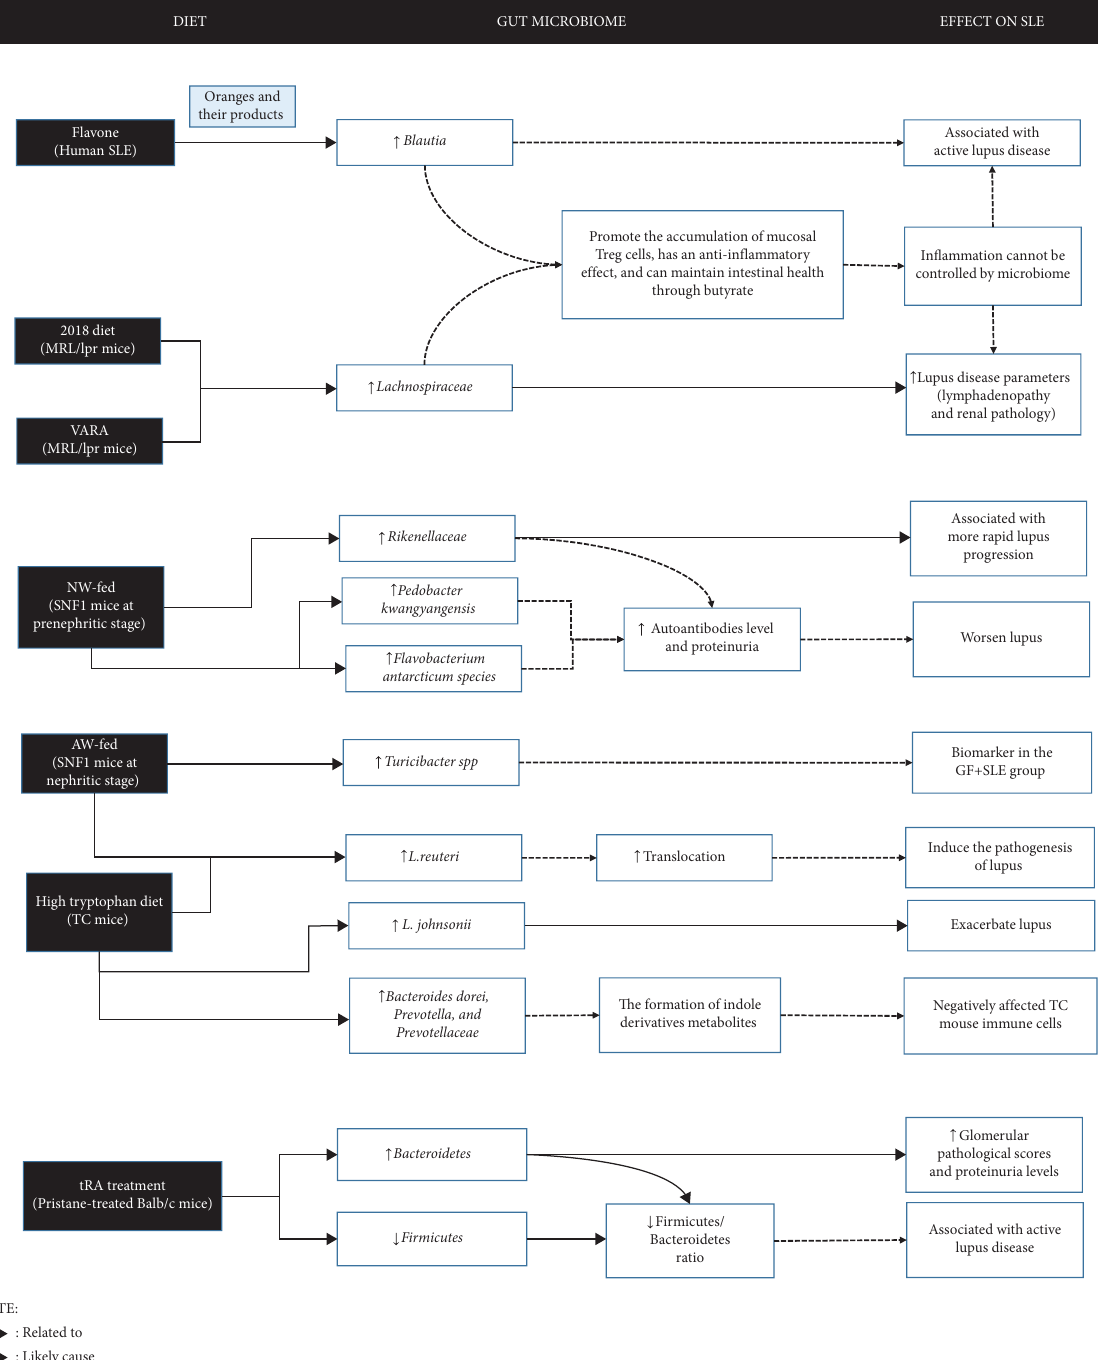
Figure 3: Emerging evidence points to a potential link between diet, gut microbiome, and worsening efect of